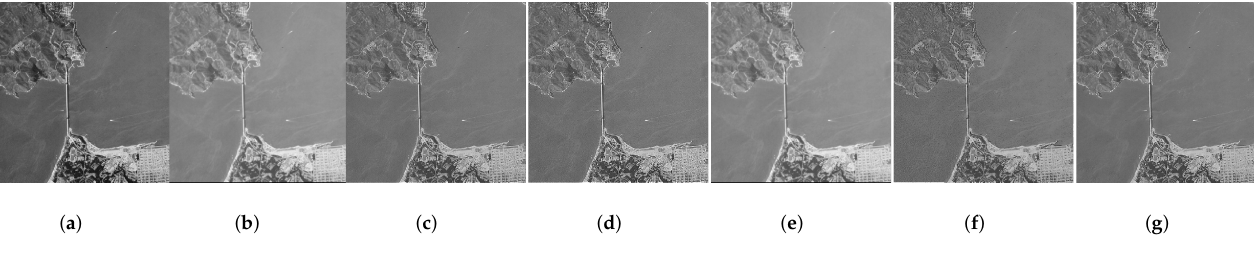
Figure 11. The renderings of aerial image under different algorithms. ( a ) Original image. ( b ) 1-order. ( c ) 0.4-order. ( d ) 0.6-order. ( e ) [17]. ( f ) [19]. ( g )